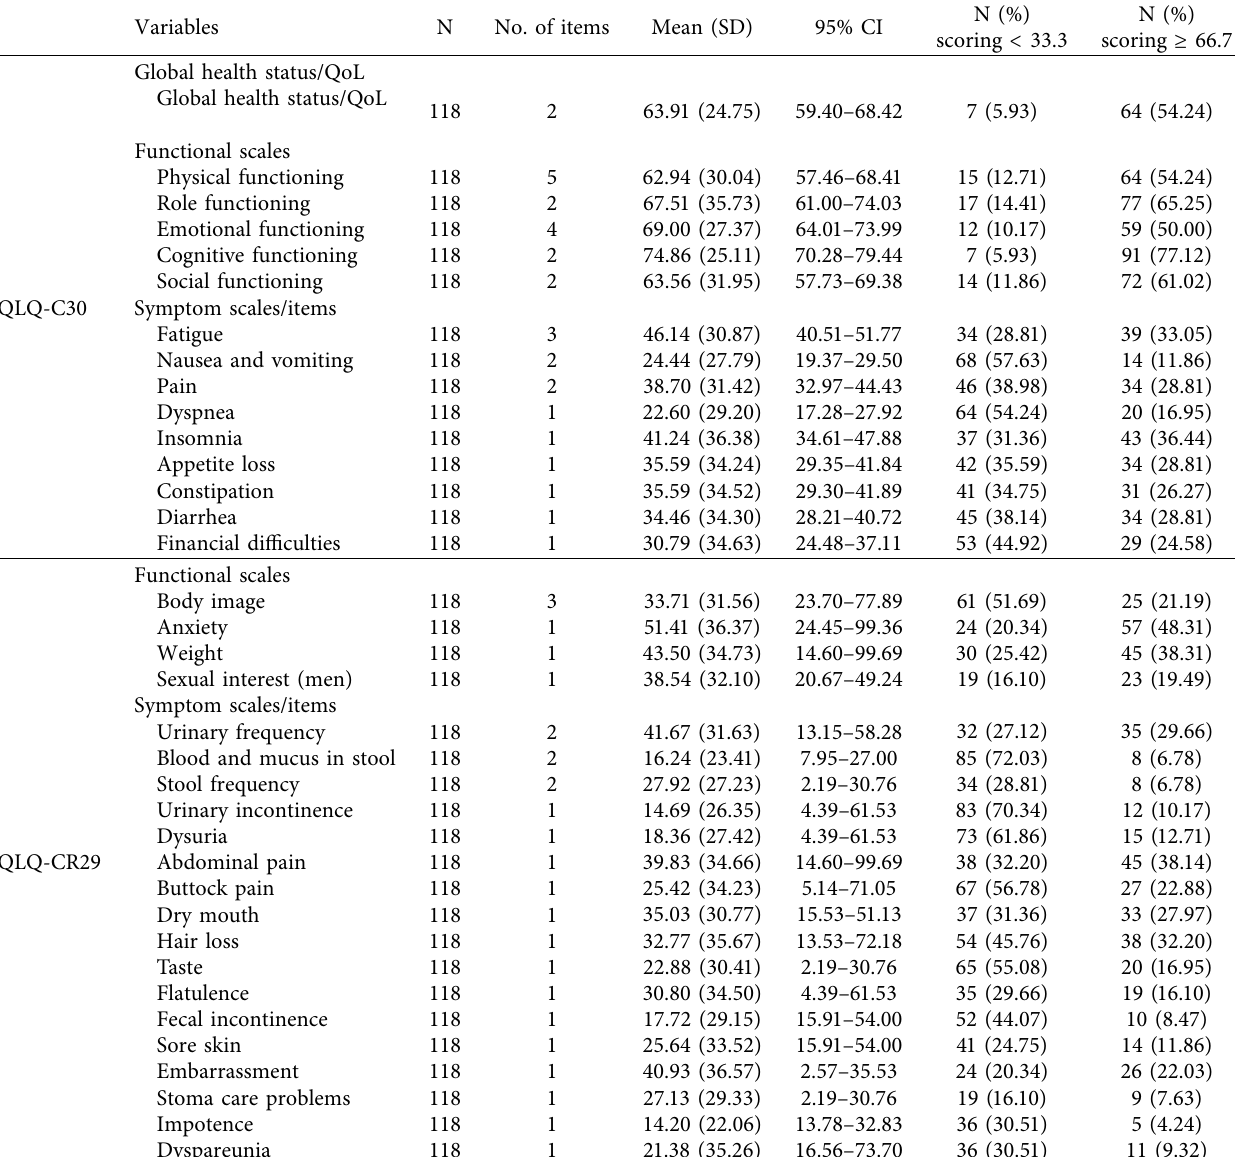
Table 2: Mean score of all items in QLQ-C30 and QLQ-C29 ( n �